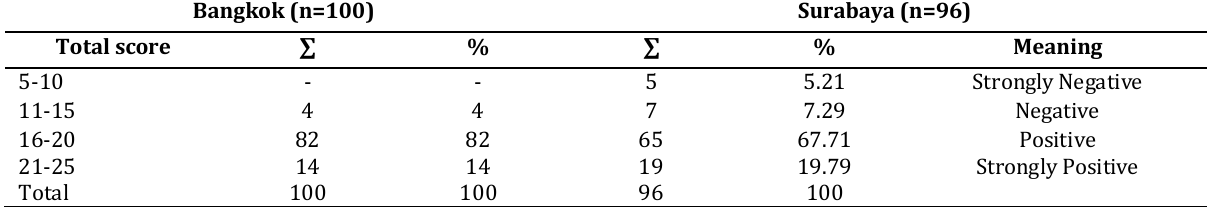
Table 4. Level of the elderly attitude towards MHE based on the total score Bangkok (n=100)